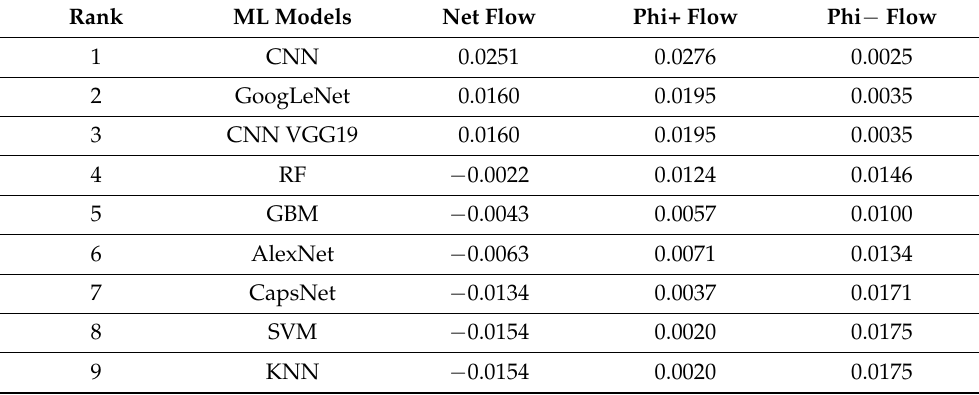
Table 3. Fuzzy-based PROMETHEE results/preference table (support vector machine (SVM), ran- dom forest (RF), gradient-boosting model (GBM), convolutional neural network (CNN), K-nearest neighbor